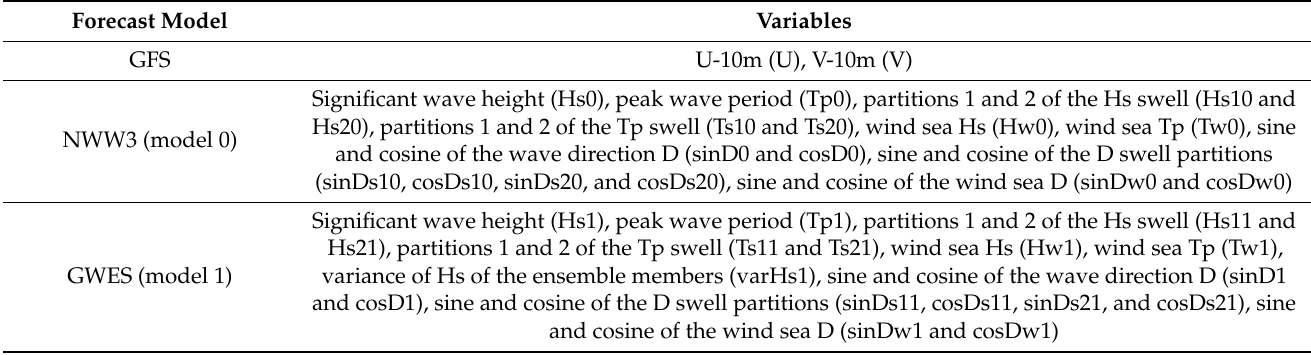
Table 1. Summary of the 35 input features, separated by forecast model. The names of the features adopted in the dataset are in the parenthesis. Forecast Model